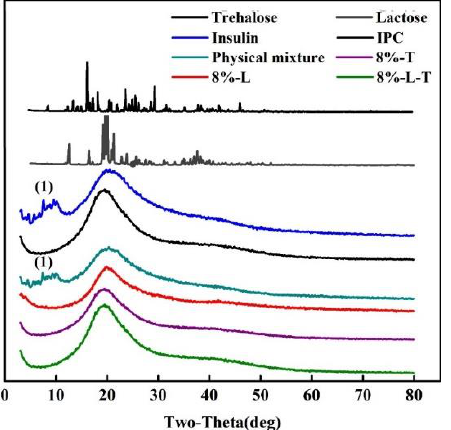
Figure 5. X-ray diffraction patterns (1 refers to diffraction peaks of insulin). Figure 5. X-ray di ff raction patterns (1 refers to di ff raction peaks of